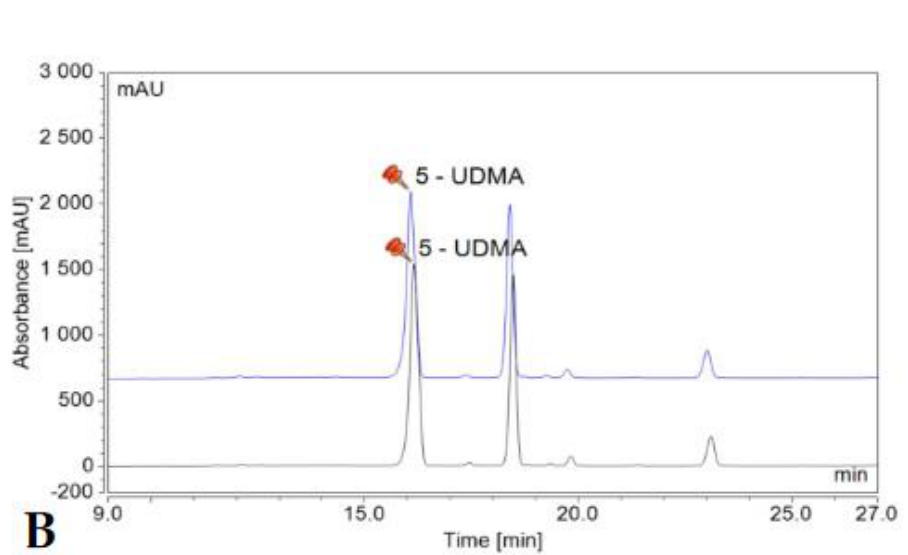
Figure 4. Comparison ( A ) of the amount of eluted monomers from room-temperature (blue bar) and pre-heated (orange bar) G-aenial Posterior samples. The * mark indicates statistically significant differences between the groups according to the independent two-tailed t -test. The chromatogram ( B ) shows the detected monomers eluting from room-temperature (black chromatogram) and pre- heated (blue chromatogram) G-aenial Posterior and their retention times based on the standard monomers, evaluated at a 205 nm wavelength. (Abbreviations: UDMA, urethane-dimethacrylate; mAU, milli-Absorbance Units).